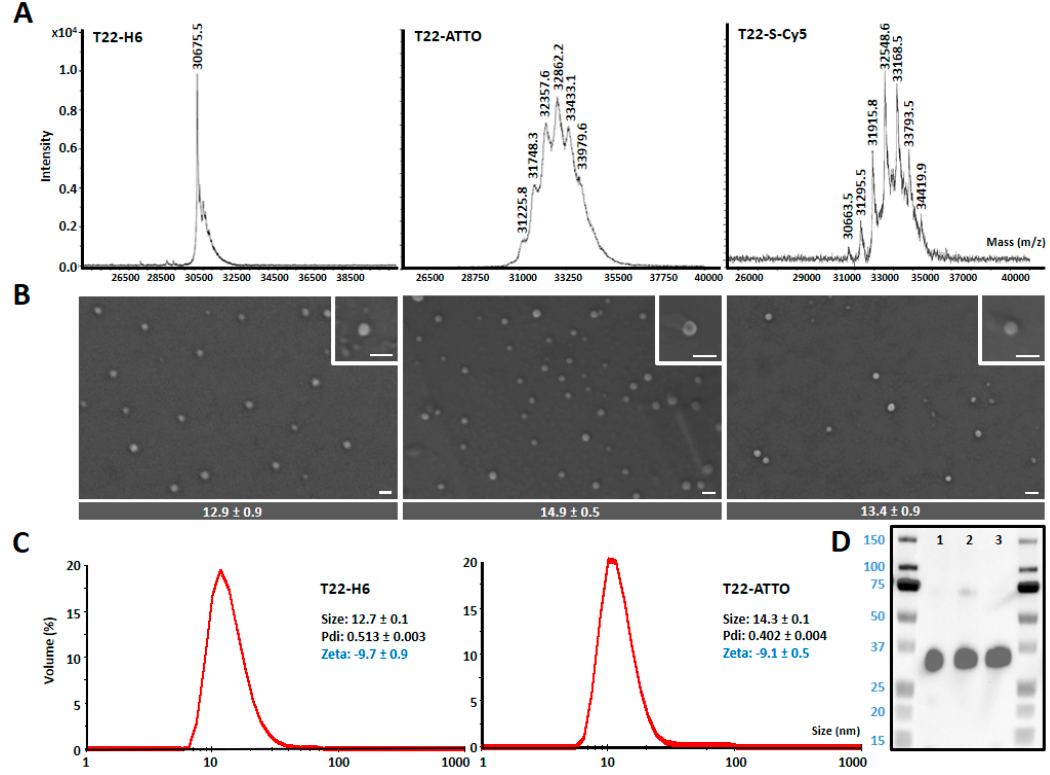
Figure 2. Nanoarchitecture of nanoconstructs. ( A ) MALDI-TOF mass spectrometry of T22-GFP-H6 (T22) nanoparticles and T22-GFP-H6-ATTO (T22-ATTO) and T22-GFP-H6-S-Cy5 (T22-S-Cy5) nanoconjugates. Each peak over 30.6 kDa (T22-GFP-H6) corresponds to the addition of a single ATTO488 or Sulfo-Cy5 molecule, respectively. ( B ) Representative electron microscopy (FESEM) images of the three nanoconstructs (nanoparticles and nanoconjugates) presented in two magnifications (see insets), equivalent in all images. Scale bars indicate 30 nm. At the bottom, quantitative average size of nanoconstructs is determined by image analysis and shown as mean ± standard error. ( C ) Volume size distribution (Size) and Z-potential (Zeta) of protein nanoparticles measured by light scattering. T22-GFP-H6-S-Cy5 sample cannot be analyzed since S-Cy5 fluorescence interferes with light scattering measurements. Pdi indicates polydispersion index. ( D ) Western blot analysis of T22-GFP-H6 (1), T22-GFP-H6-S-Cy5 (2) and T22-GFP-H6-ATTO (3) immunodetected by an anti-GFP monoclonal antibody.